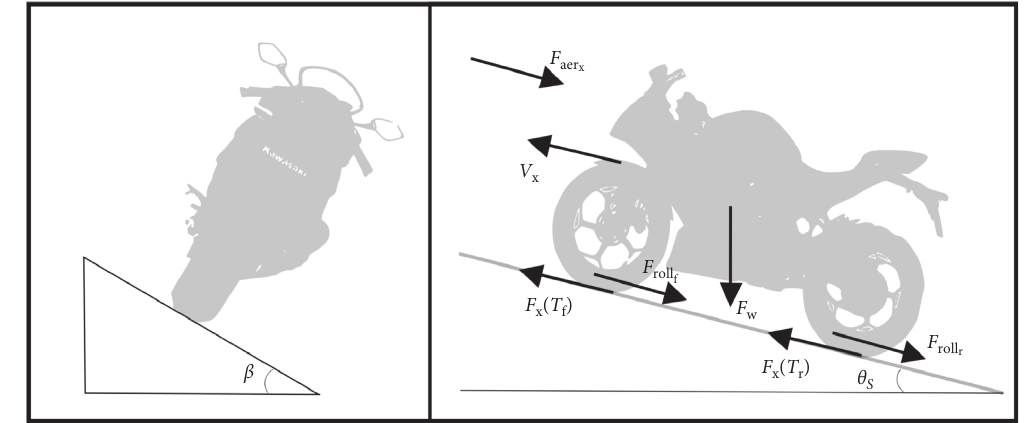
Figure 1: Forces involved in longitudinal